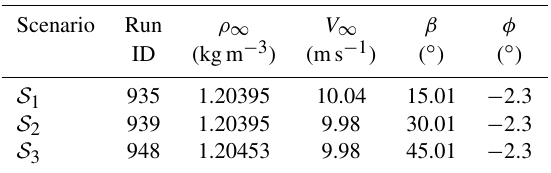
Figure 2. New MEXICO rotor tested in the DNW-LLF wind tunnel (Boorsma and Schepers, 2014, 2016). Table 1. New MEXICO operating conditions considered for yaw model